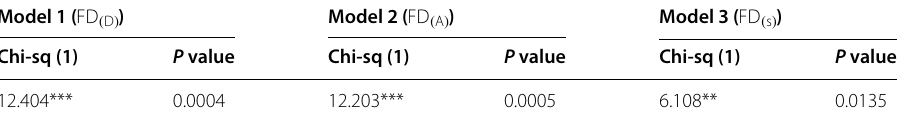
Table 5 Endogeneity test results